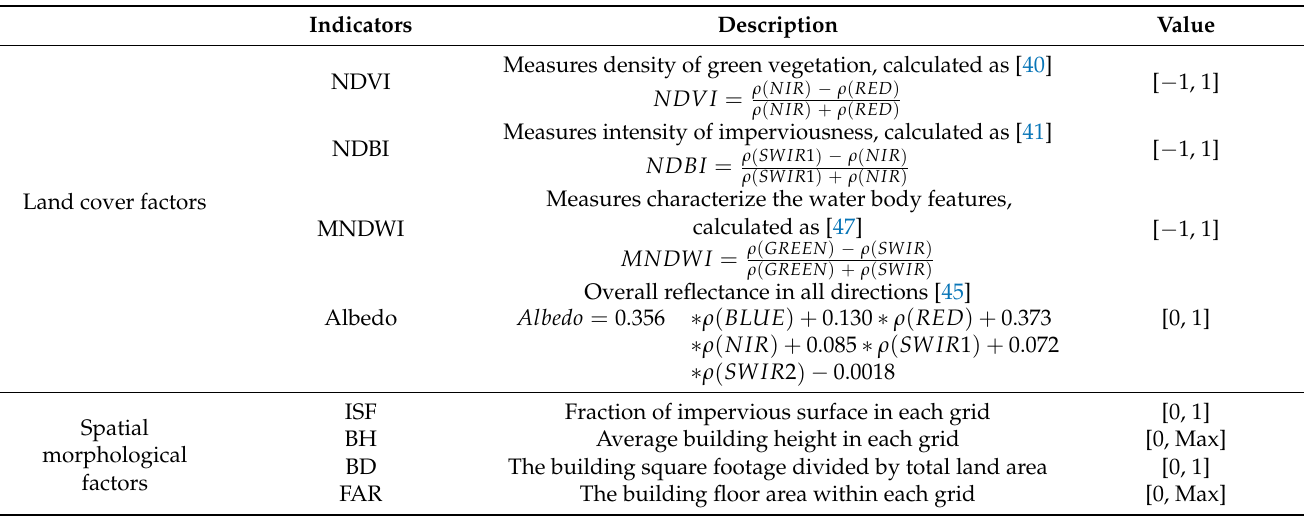
Table 3. Detailed description about the selected